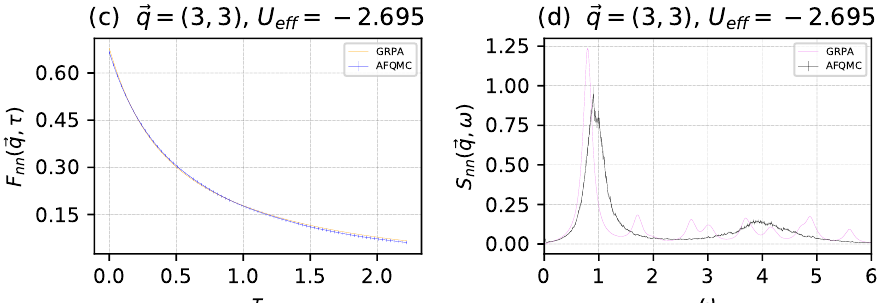
Figure 5. For momenta q = ( 3,3 ) , in units of 2 π : The density–density, imaginary-time intermediate L scattering function F nn ( q , τ ) for the physical potential U = − 4.0 ( a ). The density–density dynamical structure factor S nn ( q , ω ) for the physical potential U = − 4.0 ( b ). The density–density, imaginary time intermediate scattering function F nn ( q , τ ) for the renormalized, effective potential U ef f = − 2.695 ( c ). The density–density dynamical structure factor S nn ( q , ω ) for the renormalized, effective potential U ef f = − 2.695 ( d ). In the left sub-panels, blue indicates AFQMC data and orange indicates GRPA data. In the right sub-panels, black indicates AFQMC data and violet indicates GRPA data.